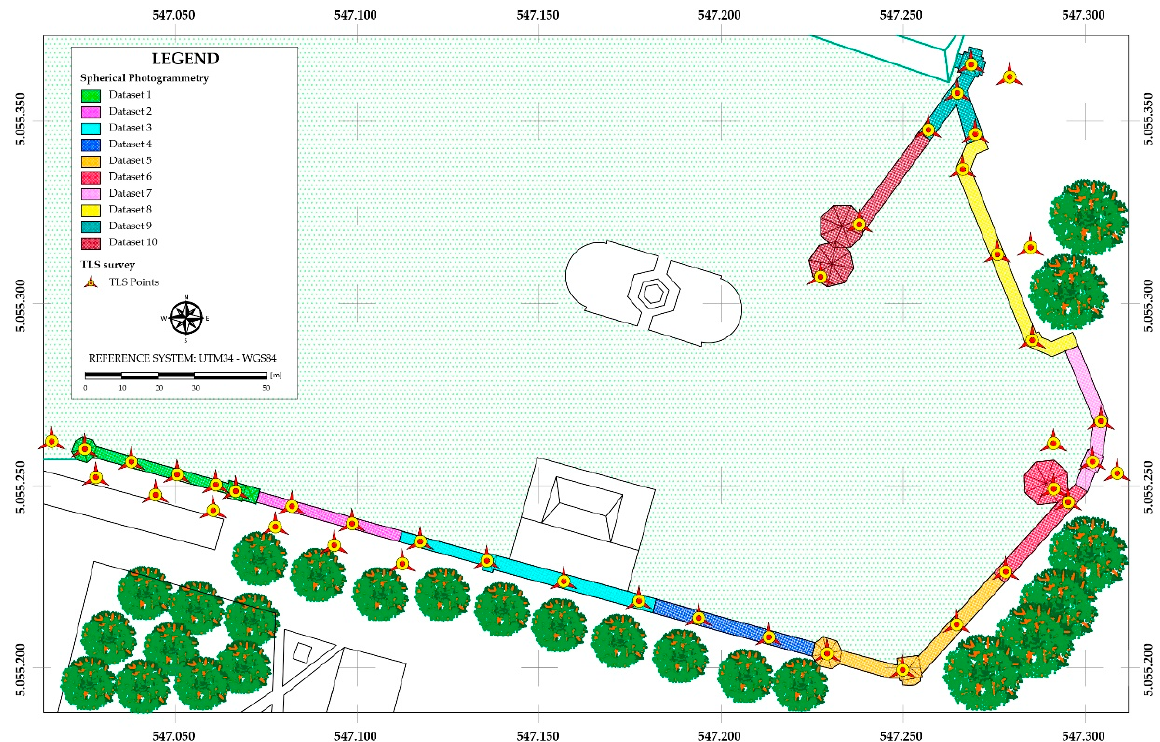
Figure 8. Plan with indication of photogrammetric datasets and TLS station positions.